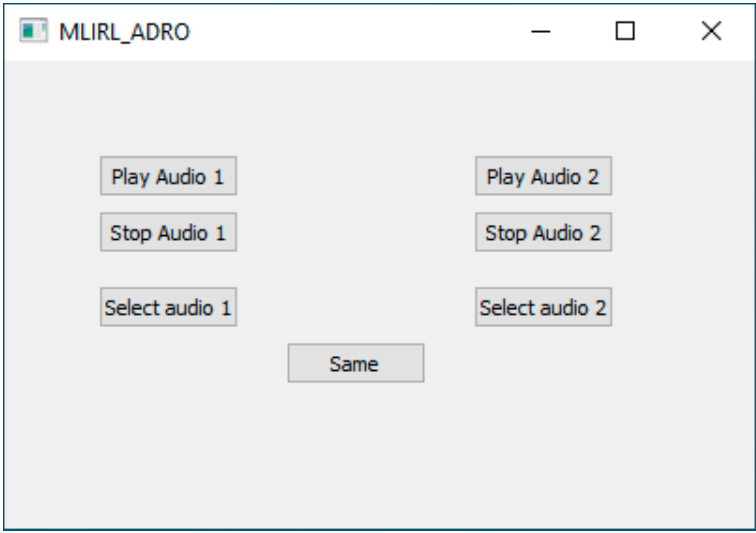
Figure 5. Graphical user interface (GUI) for establishing the preference model of a subject.